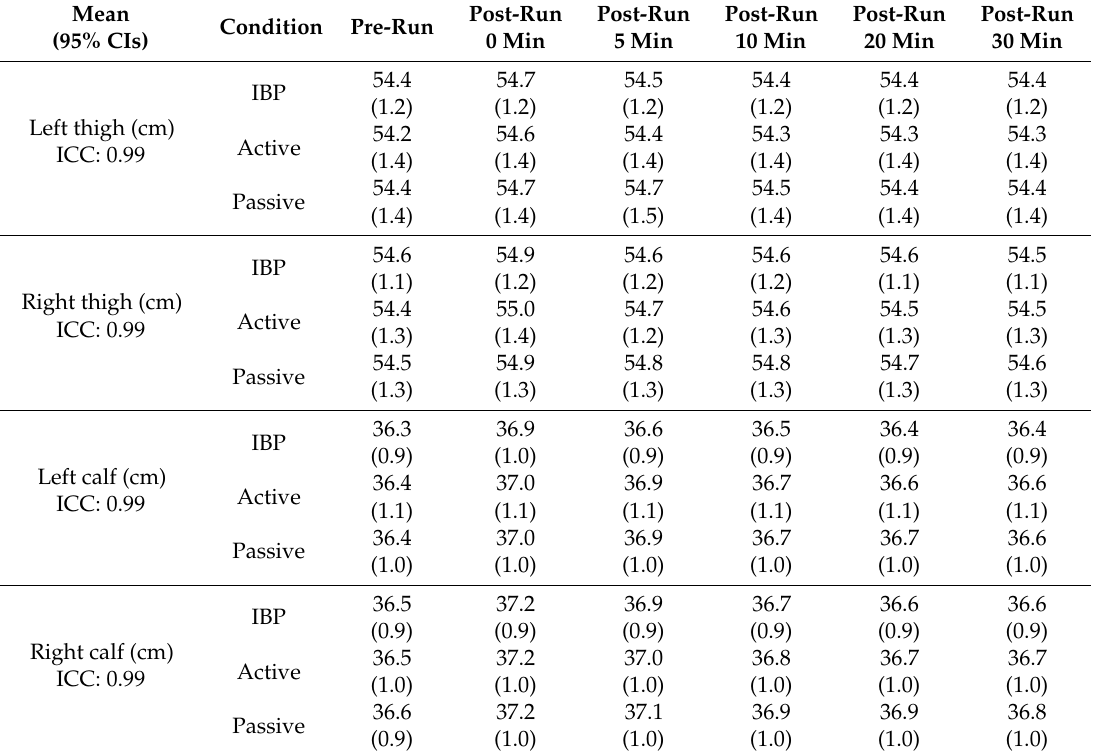
Table 2. Changes in circumference of